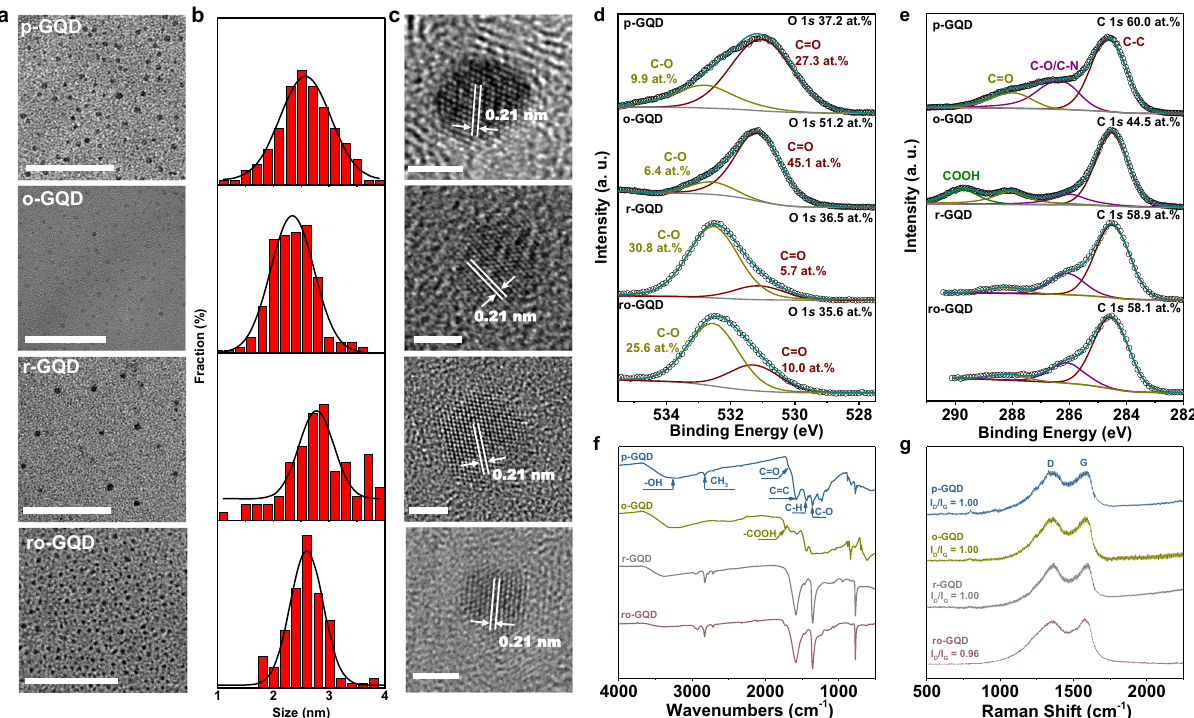
Fig. 2 Structural and surface characterization of the p-GQDs, o-GQDs, r-GQDs, and ro-GQDs. a – c TEM images ( a ), the lateral size distributions ( b ), and HRTEM images ( c ) of p-GQDs, o-GQDs, r-GQDs, and ro-GQDs (from top to bottom). Scale bar: 50 nm for Fig. 2a and 2 nm for Fig. 2c. d and e The high- resolution O 1 s ( d ) and C 1 s ( e ) spectra of p-GQDs, o-GQDs, r-GQDs, and ro-GQDs. f The FTIR spectra of p-GQDs, o-GQDs, r-GQDs, and ro-GQDs. The FTIR and XPS spectra together prove the prevalence of – OH groups on both r-GQDs and ro-GQDs. On the contrary, p-GQDs comprise a majority of – C = O groups, and o-GQDs have a predominance of – COOH and – C = O groups. g The Raman spectra of p-GQDs, o-GQDs, r-GQDs, and ro-GQDs, showing that these four GQDs have a similar graphitization